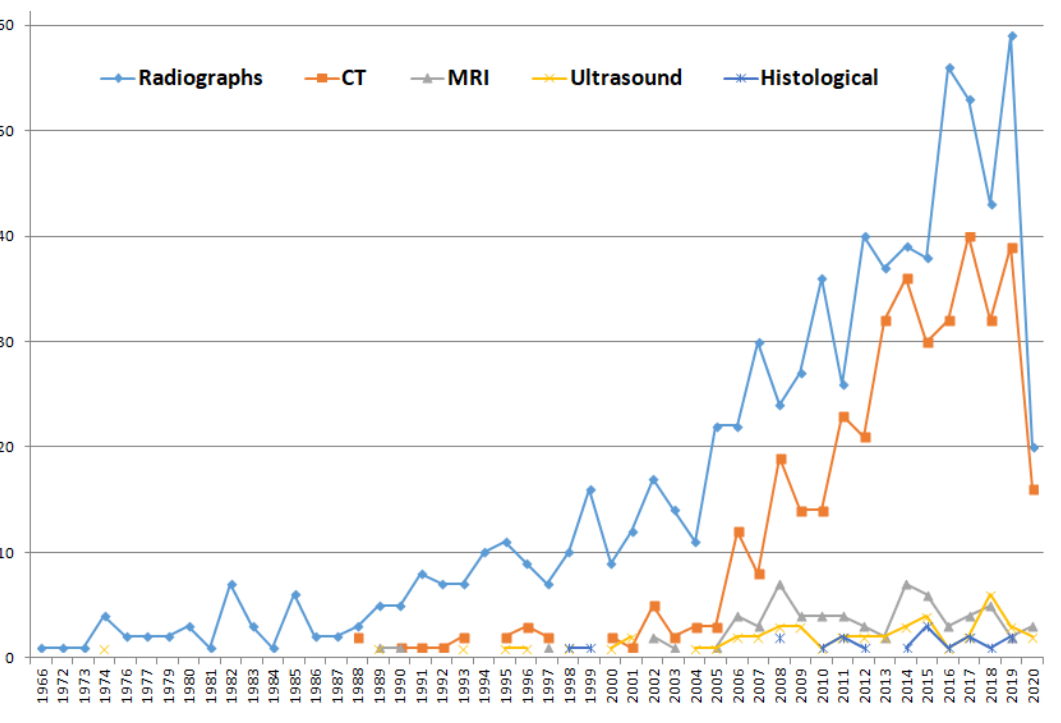
Figure 1. Papers published using different biomedical image modalities for forensic ID. This figure was obtained by introducing the following queries in Scopus (search performed the 11th of May 2020): (TITLE-ABS-KEY(forensic identification radiograph) OR (TITLE-ABS-KEY(forensic identification X-ray image))); (TITLE-ABS-KEY(forensic identification CT)); (TITLE-ABS-KEY(forensic identification MRI)); (TITLE-ABS-KEY(forensic identification ultrasound)); and TITLE-ABS-KEY (forensic identification histological image). Those searches provided 771, 398, 68, 49 and 18 papers, respectively. The most commonly employed biomedical image modalities in this domain are X-ray images and computed tomographies